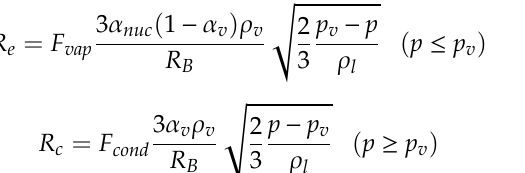
Table 2. Properties of water and water vapor.